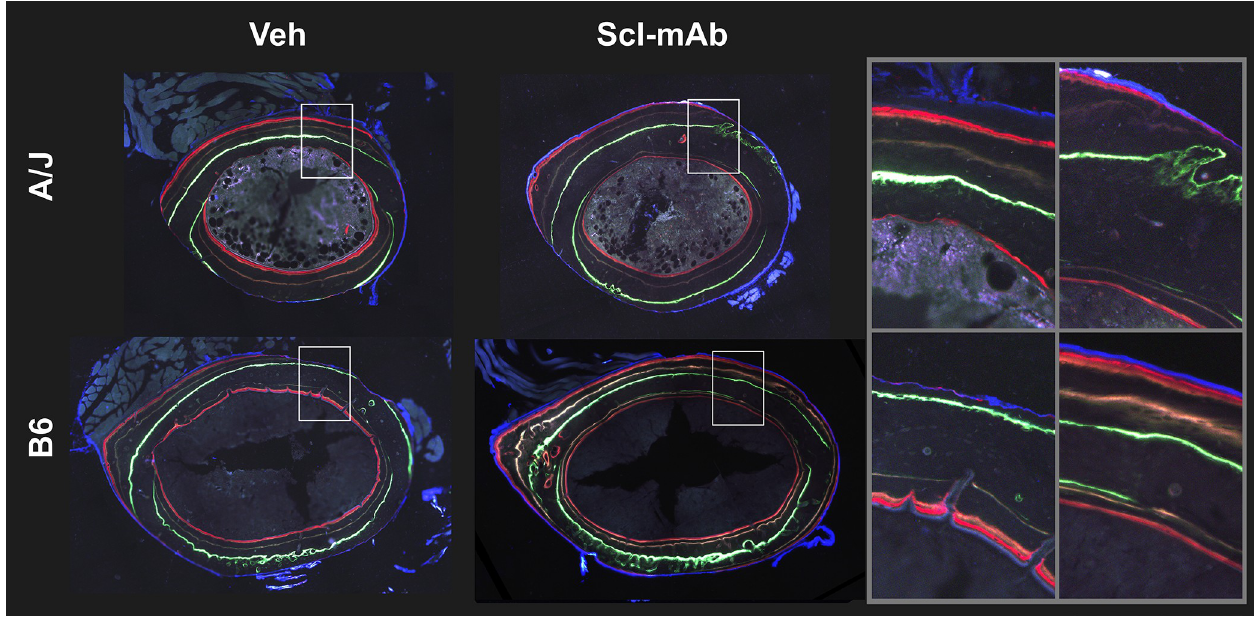
Fig 6. Representative histological images of the 4 fluorescent bone labels for treated and untreated A/J and B6 mice. Calcein was administered at 4 weeks of age, oxytetracycline HCL was administered at 6 weeks of age, demeocolcyline was administered at 7.5 weeks of age, and alizarin complexone was administered at 8 weeks of